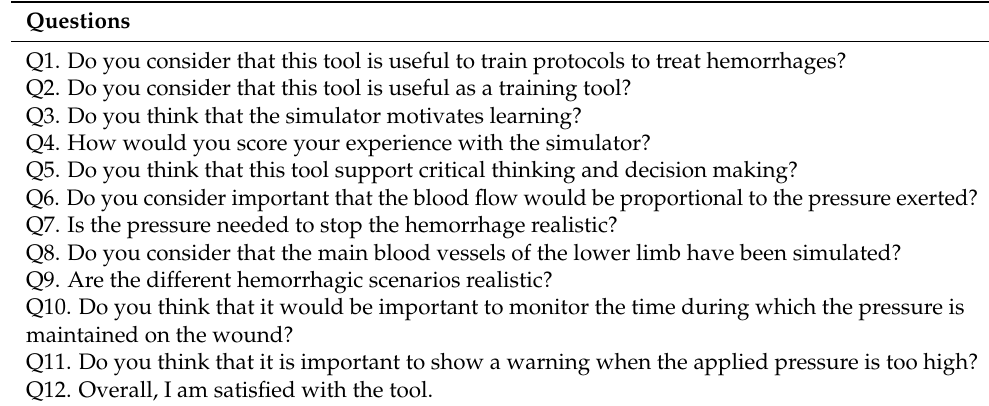
Table 4. Questions of the usability questionnaire.